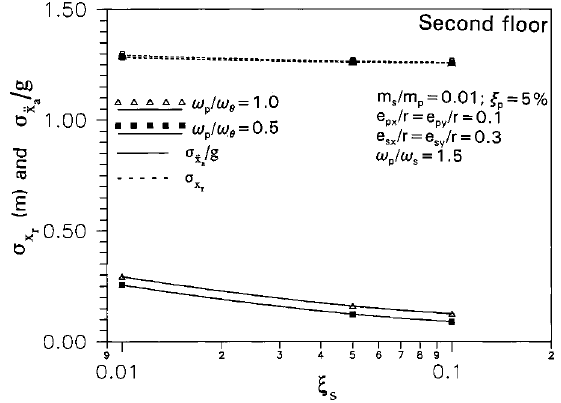
=g with e s x =r and e s y =r ; for sec- Fig. 16. Variation of (cid:27) x and (cid:27) (cid:127) x r a ond floor level, for m s =m p = 0.01; ! p =! s = 1.0; ! p =! (cid:18) = 1.0 and 0.5; e p x =r = e p y =r = 0.1; (cid:24) p = 5% and (cid:24) s = 2%.